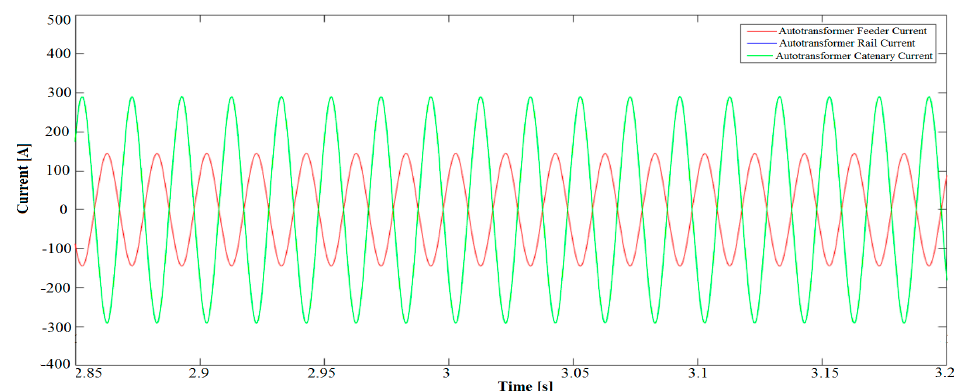
Figure 20. Voltage at the train pantograph and current drawn.